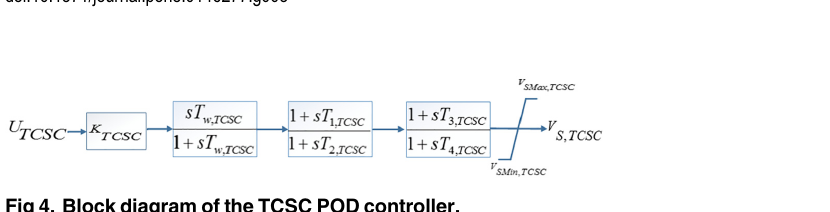
Fig 3. Modeling of a TCSC: a) TCSC location in a transmission line. b) Representation of the voltage source in the current source. C) Current injection model.